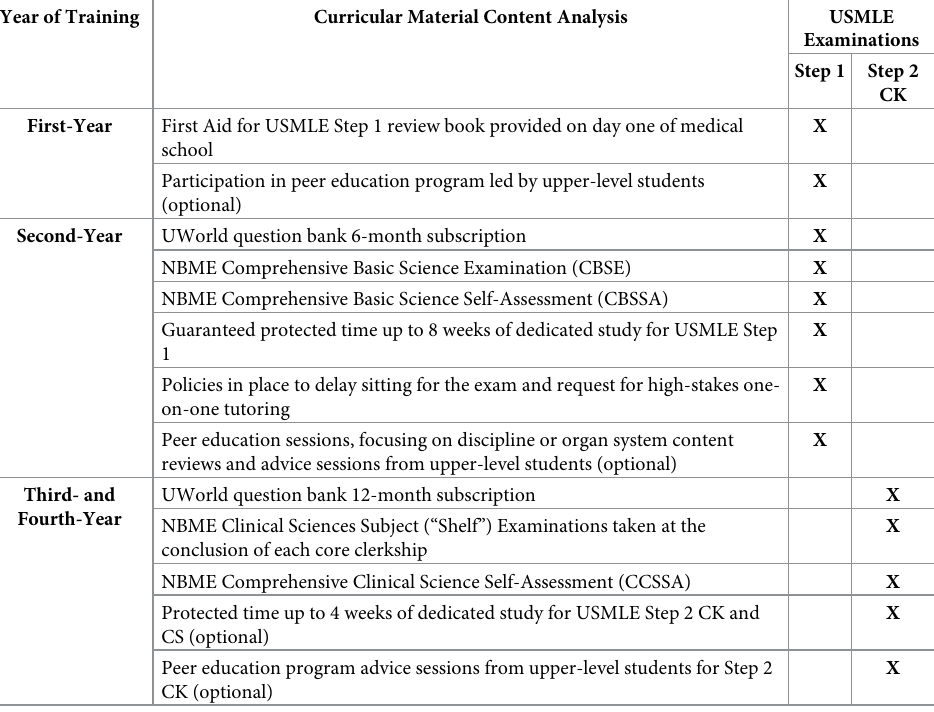
Table 2. Content analysis of parallel curricular materials offered to medical students at A single institution for preparation for USMLE